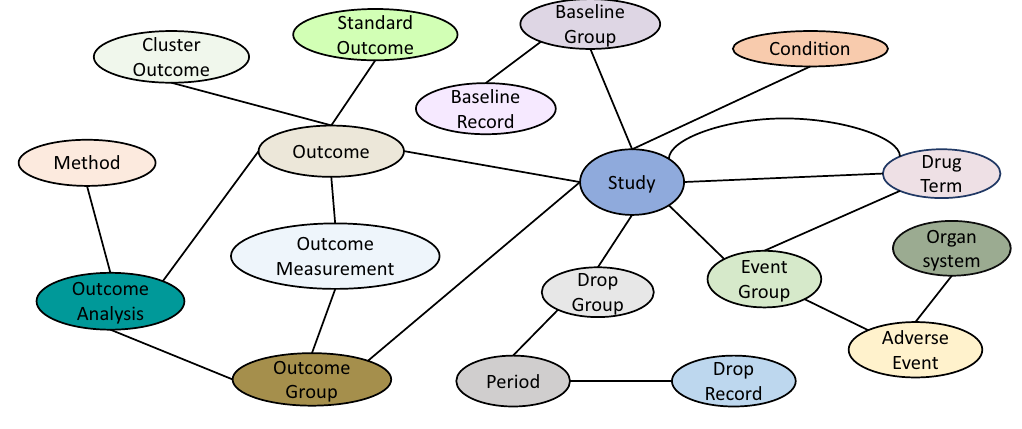
Figure 1. Schema of CTKG .